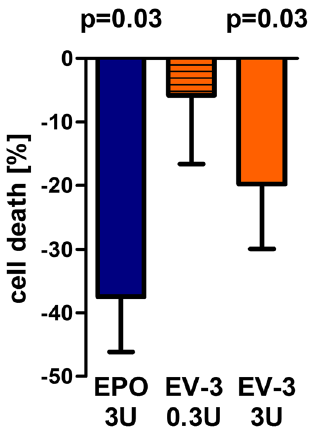
Figure 7. EV-3 and EPO protect primary hippocampal neurons from cell death. Pretreatment with EPO or EV-3 reduced cell death, induced by starvation (48 h) followed by hypoxia (20 h), of rat primary hippocampal neurons (n = 5/treatment; hypoxia effect set to 100%; one-tailed paired t-test, EPO and EV-3 [U weight equivalents] treatment compared to placebo). Mean ± SEM